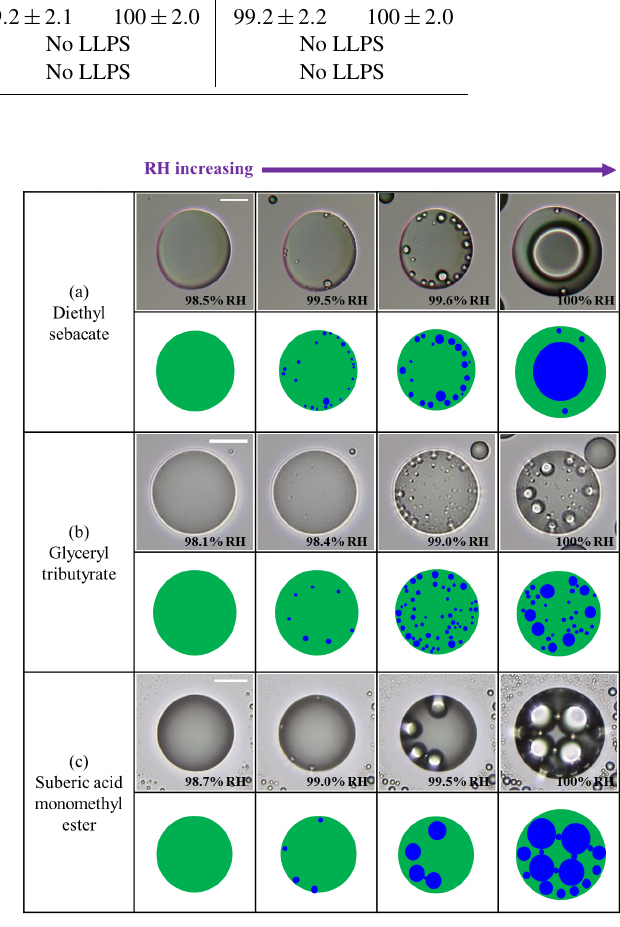
Figure 1. Optical images of single particles consisting of one or- ganic species with decreasing RH: (a) diethyl sebacate particles, (b) glyceryl tributyrate particles, and (c) suberic acid monomethyl ester particles. The ”streaks” extending from the inclusions to the edge of the particles in (b) and (c) are an optical effect. Illustra- tions are presented below the images. Green: organic-rich phase. Blue: water-rich phase. The scale bar is 20µm.